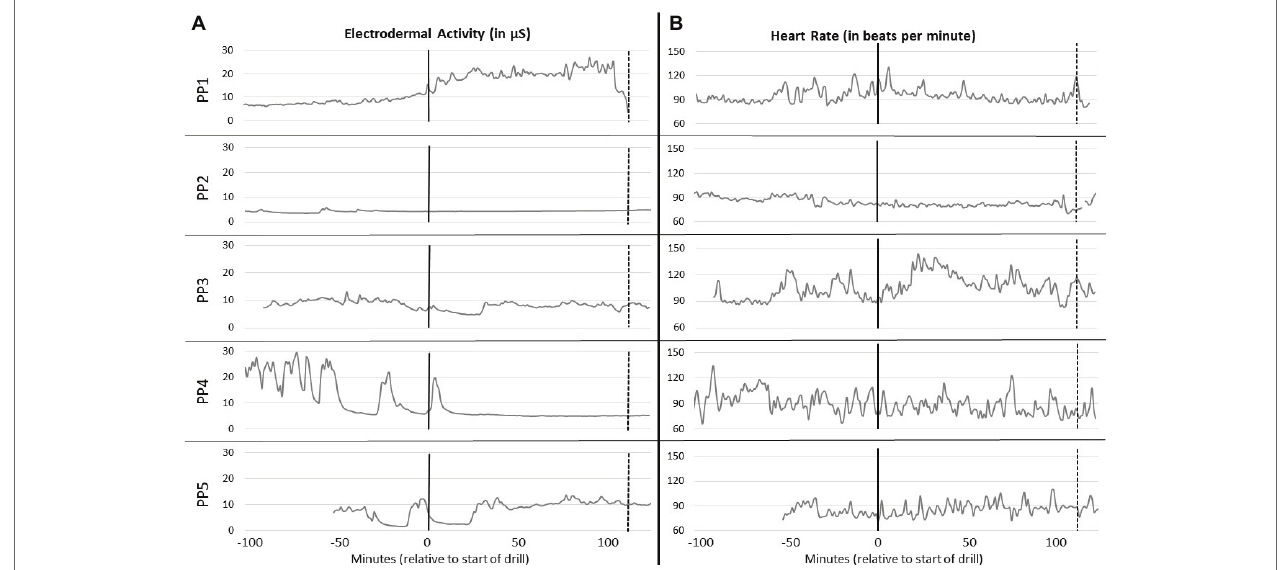
FIGURE 2 | Electrodermal activity and estimated heart rate for five individuals throughout emergency training drill. Time in minutes relative to the start of the drill is shown on the x -axis. The start of the drill is marked with a solid vertical line and the end of the drill is marked with a dashed vertical line on each graph. (A) shows electrodermal activity in microsiemens (μS) for the five participants (PP1, PP2, PP3, PP4, and PP5) throughout the study. (B) shows estimated heart rate (HR) in beats per minute for the same five participants throughout the study. Each row contains EDA and HR data for the same participant. For both physiological variables, an average value was taken for each 1 min of recording, and these averages are plotted